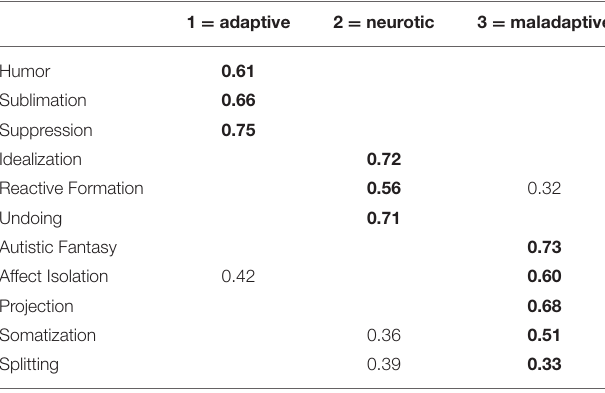
TABLE 3 | DSQ-22-A factor loadings > 0.30 of the selected 11 defense